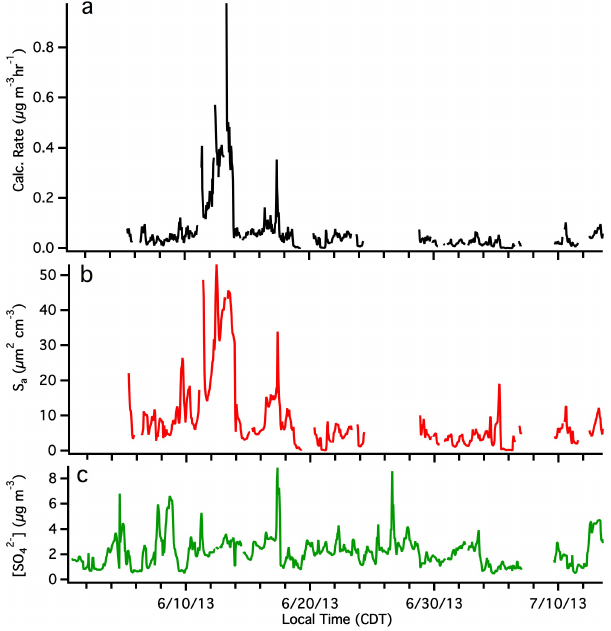
Figure 6. (a) The rate of nitrate production from mineral cations during the 2013 SOAS campaign was calculated from HNO 3 con- centrations and (b) the estimated aerosol surface area of particles between 0.7–2.5µm diameters. This rate is compared with fac- tors that contribute to NO − production, such as (b) the estimated 3 aerosol surface area and (c) SO 2 − concentrations, used as a proxy 4 for aerosol acidity. Higher NO − concentrations (Fig. 1) correlate 3 most strongly with higher PM 2 . 5 surface